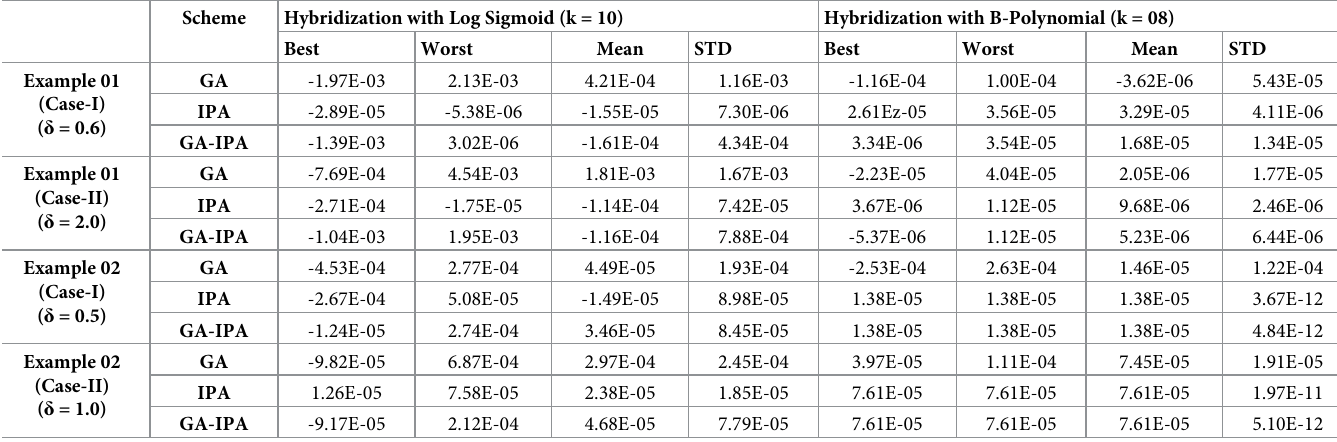
Fig 8. Graphical representation of average absolute errors for Example #02 when δ = 1.0 using B-Polynomial. https://doi.org/10.1371/journal.pone.0191103.g008 Table 20. Statistical analysis for heat transfer